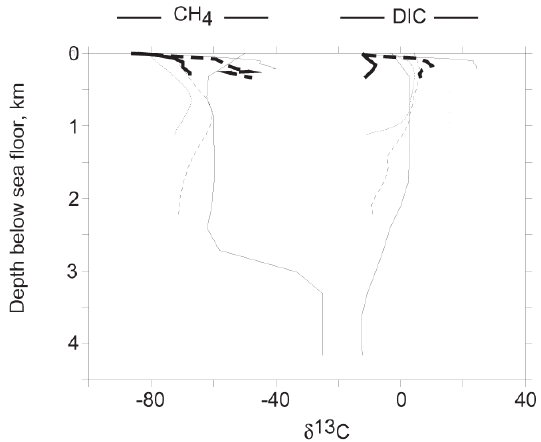
Fig. 13. Carbon isotopic compositions compared with measure- ments from Pohlman et al. (2009). Short dashes are near the toe, long dashes intermediate, and solid lines are closest inshore. Heavy lines are data; thin lines are model results.